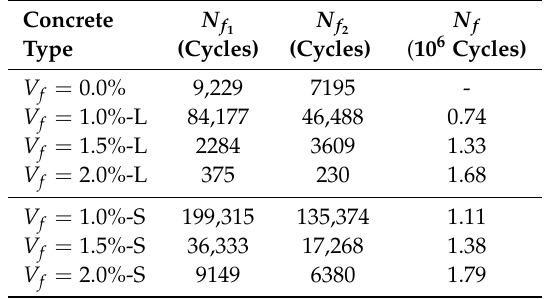
Table 7. Comparison of the mean fatigue life cycles given by Mohammadi and Kaushik [17], N f and those predicted by inverting Equation (8), N f , for the tests in [17] at a stress level of 80%. N f is the 2 predicted mean fatigue life when σ max is set at the static strength of the plain concrete. N f N f Concrete N f 1 2 Type (Cycles) (Cycles) ( 10 6 Cycles) V f = 0.0%